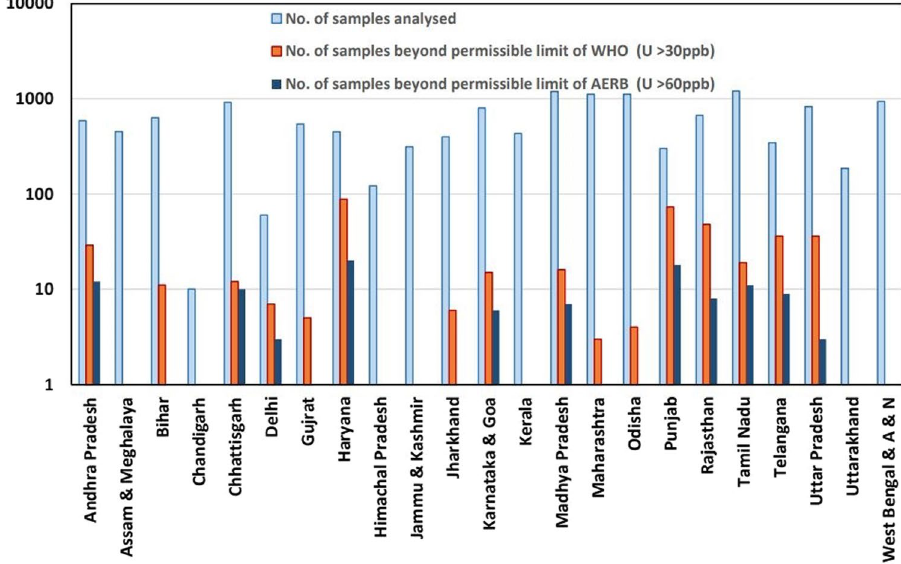
Fig. 8 Status of Uranium in groundwater of different States/ Union Territories in